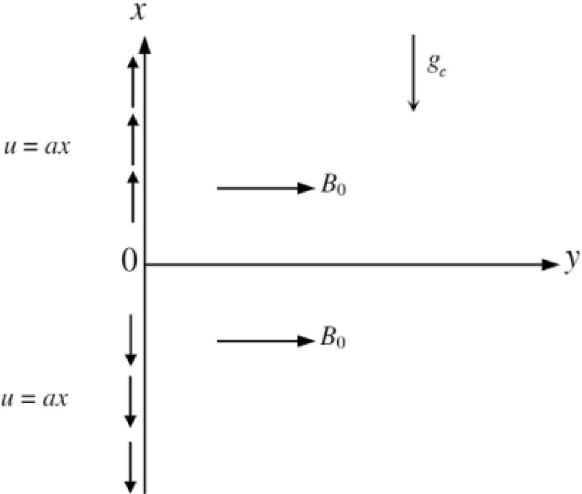
Figure 1. Physical configuration of the